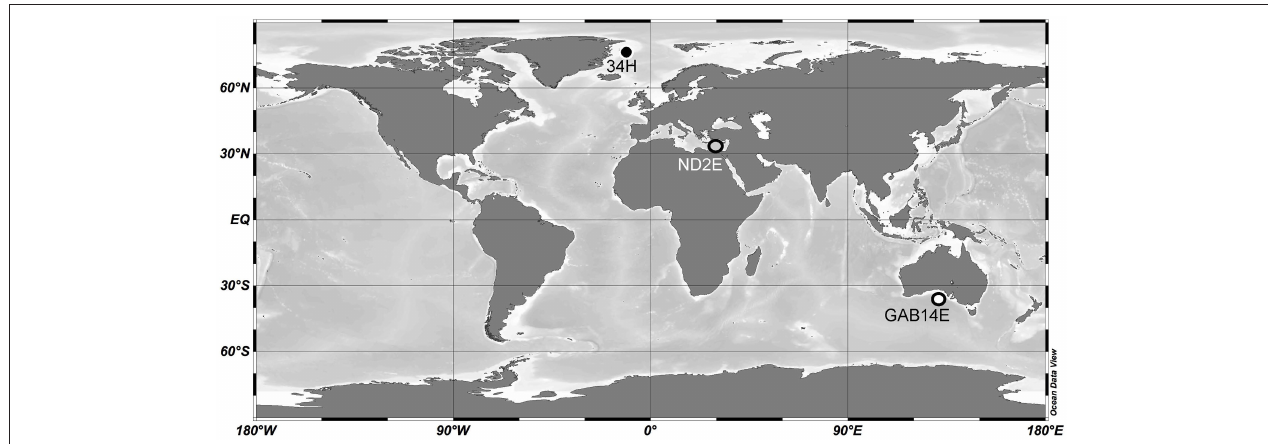
FIGURE 1 | Map of sampling locations for strains 34H, ND2E, and GAB14E. Locations are shown as circles and the strain that originated from that location is indicated by text.